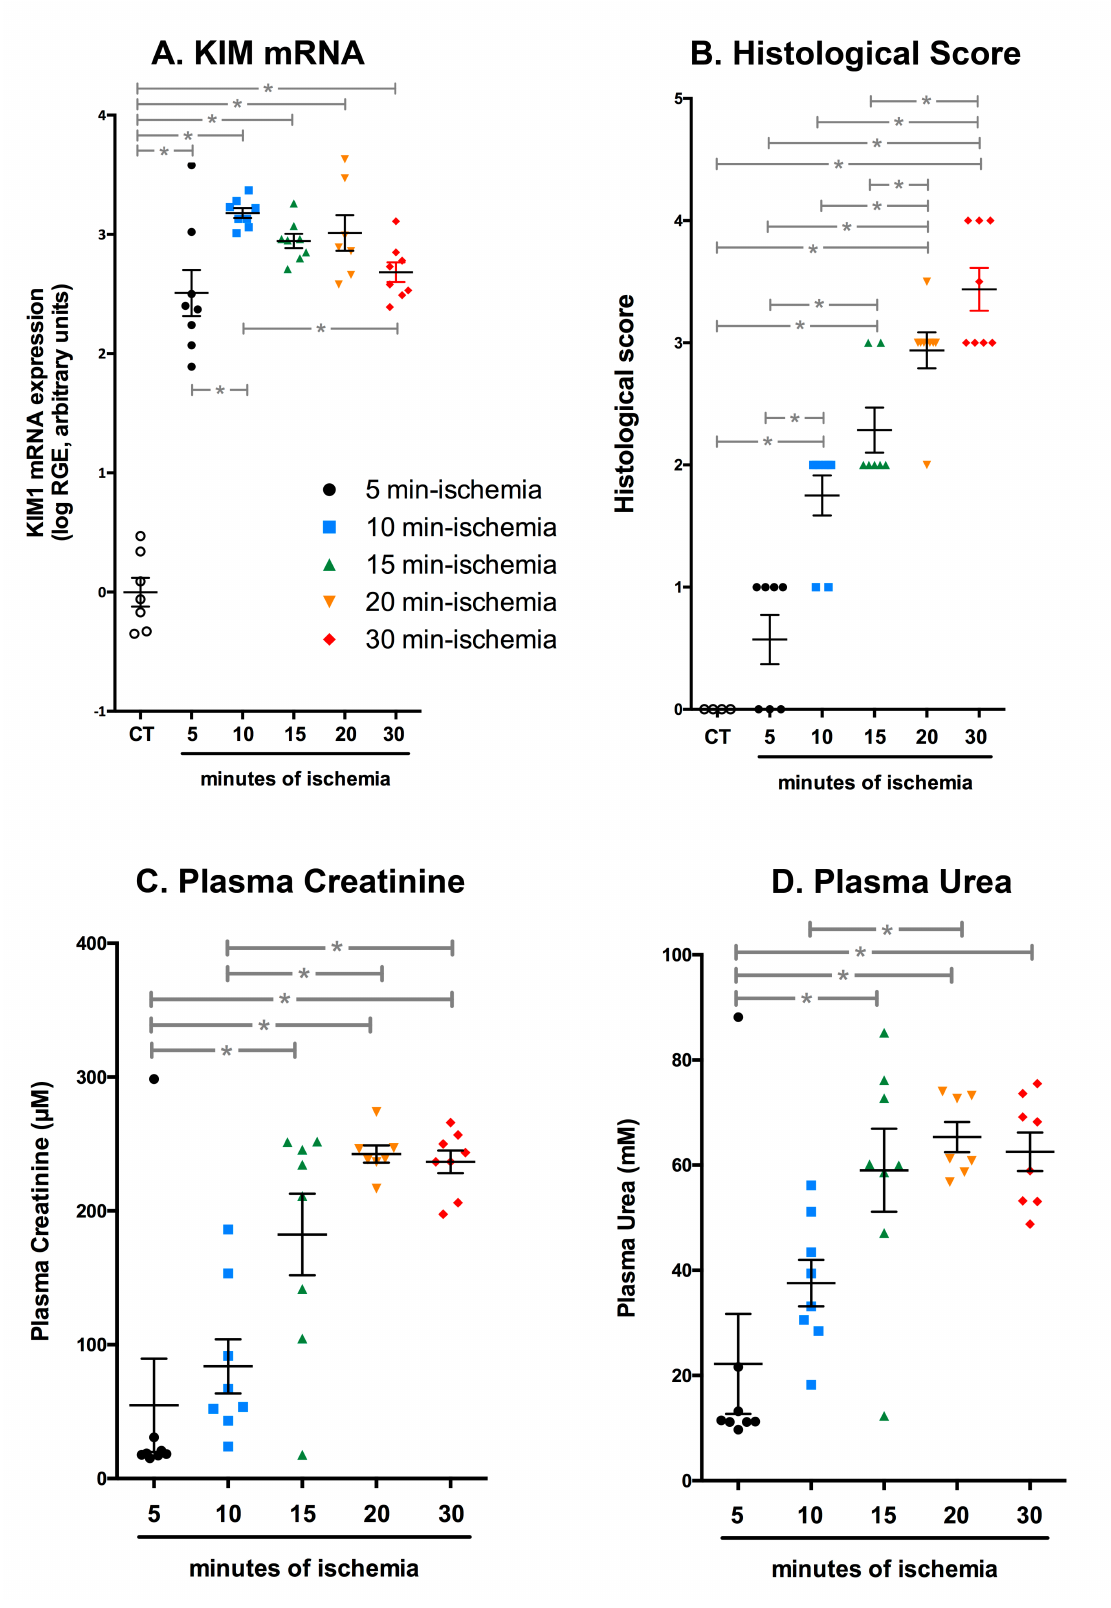
Figure 5. Ten minutes of ischemia with the RIRI clamp in conscious animals induce a similar alteration of the renal structure and function than a 30-min ischemia in anaesthetised mice. ( A ) Quantification by quantitative reverse transcription polymerase chain reaction (RT-qPCR) of the level of KIM1 transcripts in the kidney of mice subjected to 5 to 30 min